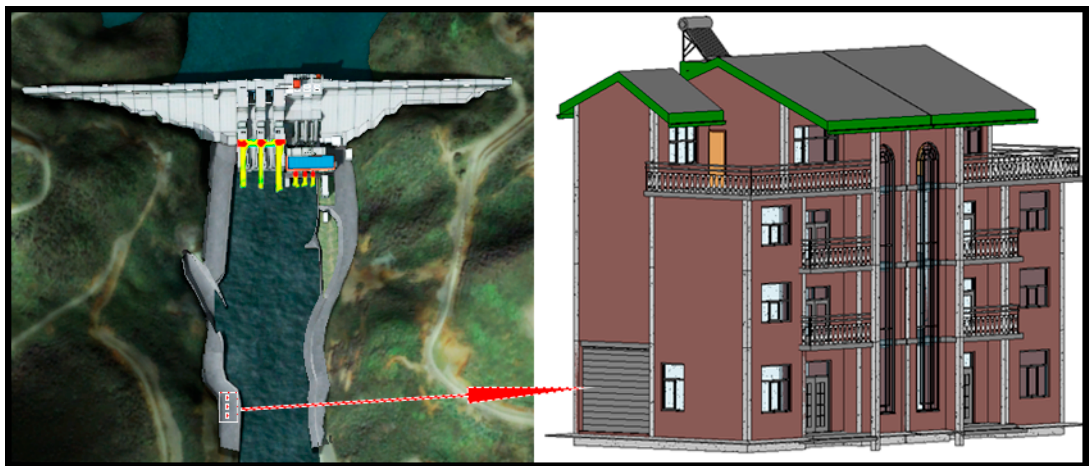
Figure 14. Location of the house and the house structures.